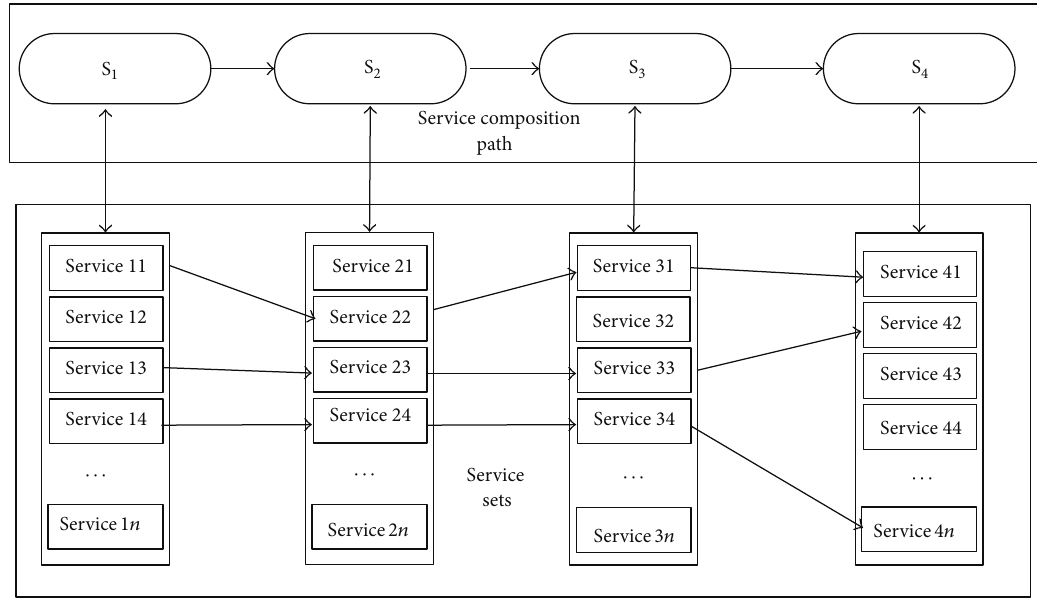
Figure 3: Service composition path